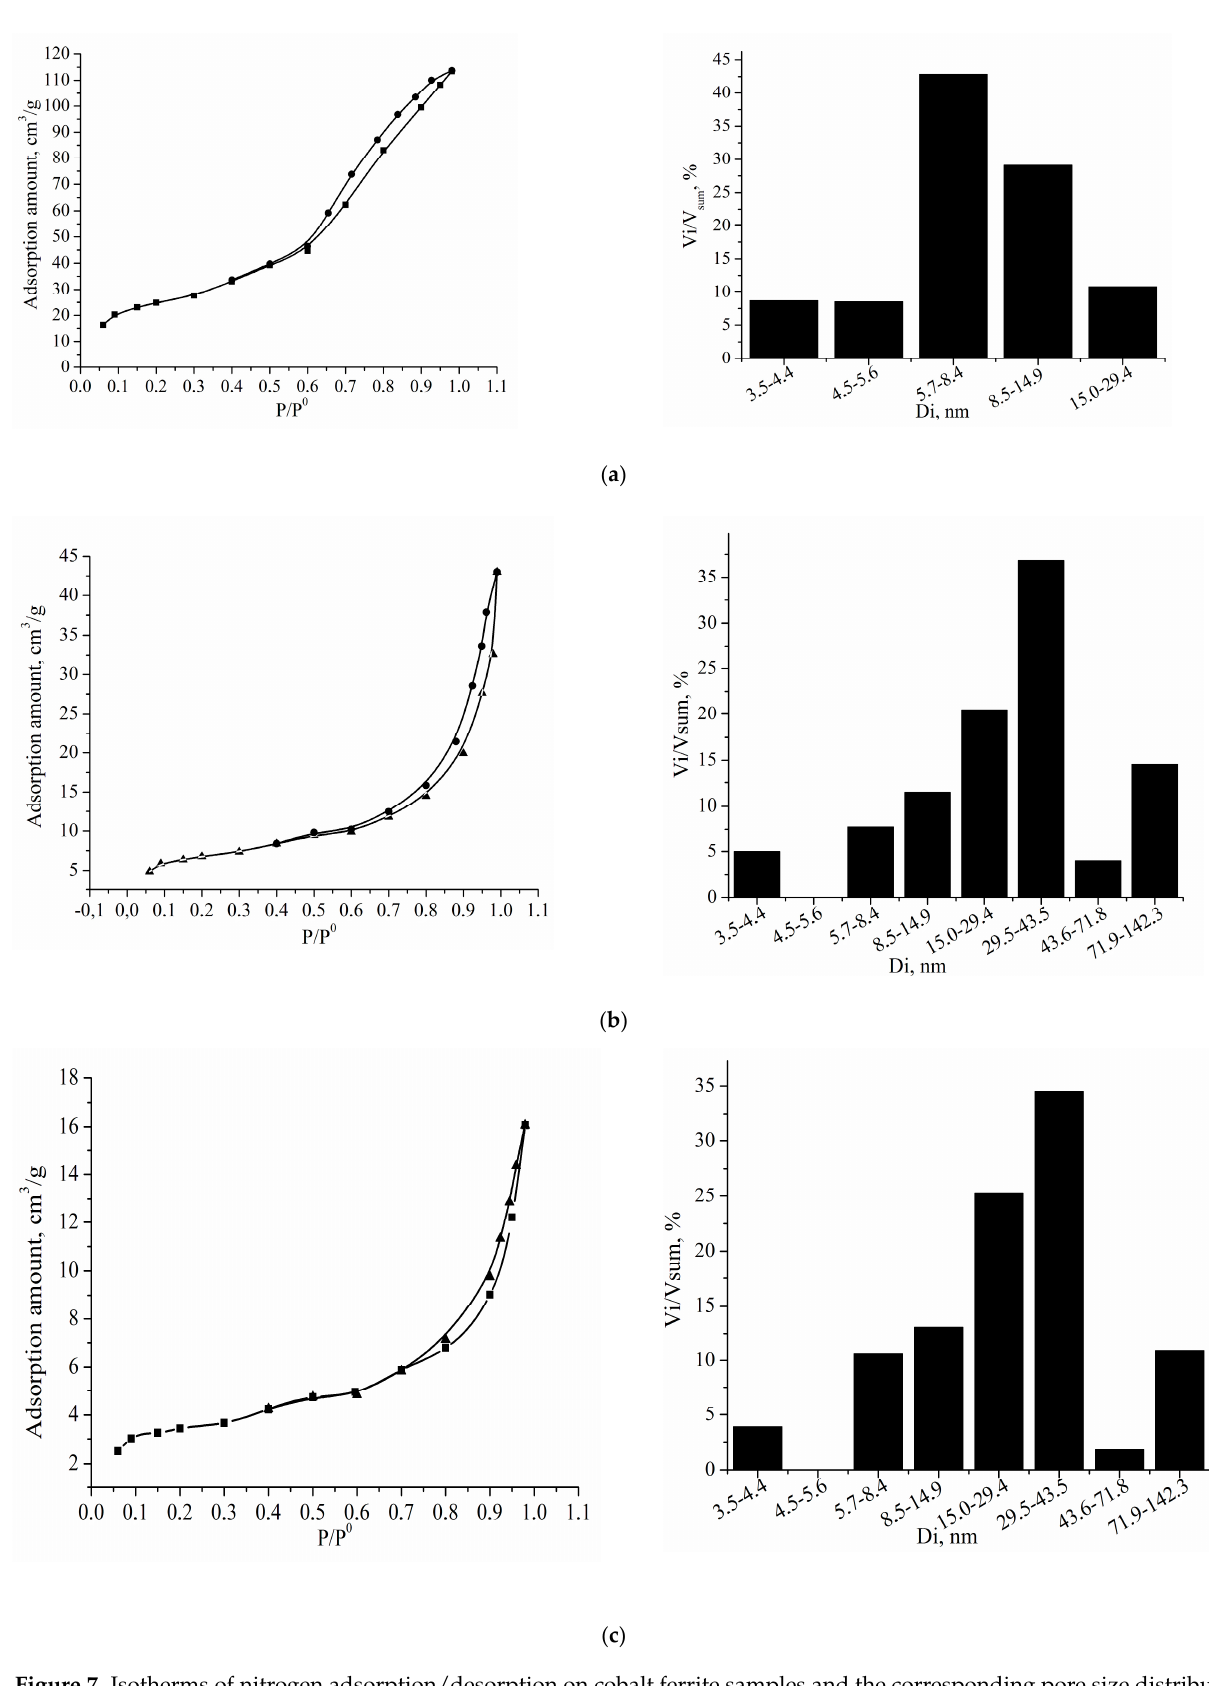
Figure 7. Isotherms of nitrogen adsorption/desorption on cobalt ferrite samples and the corresponding pore size distributions. Heat treatment temperature, ° С : ( a )—300, ( b )—400, ( c )—450.